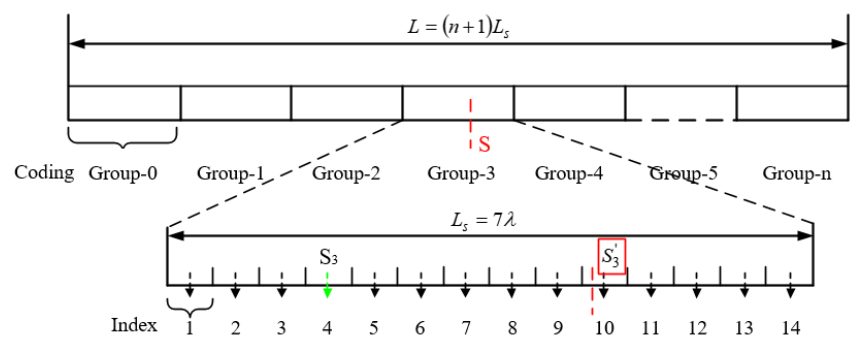
Figure 7. Schematic diagram of the absolute displacement measurement of the sensor.